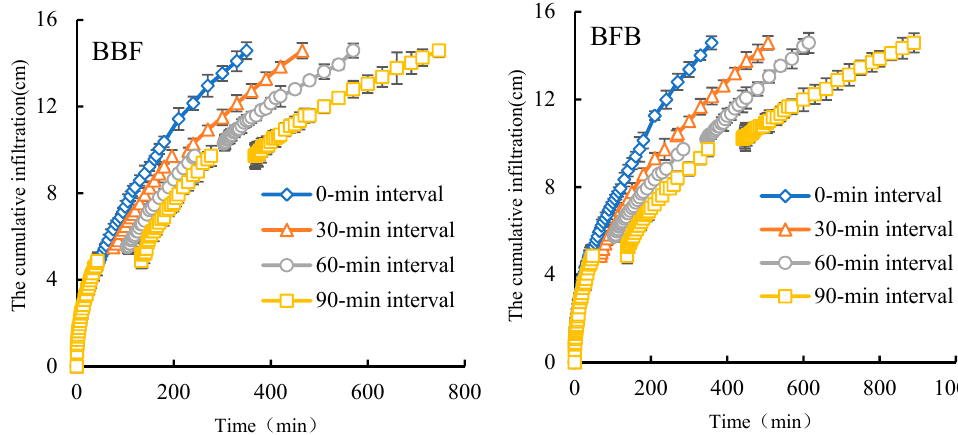
Figure 2. Changes in cumulative infiltration of water in the silty loam under different irrigation treatments (BBF, brackish-brackish-fresh water; BFB, brackish-fresh-brackish water).